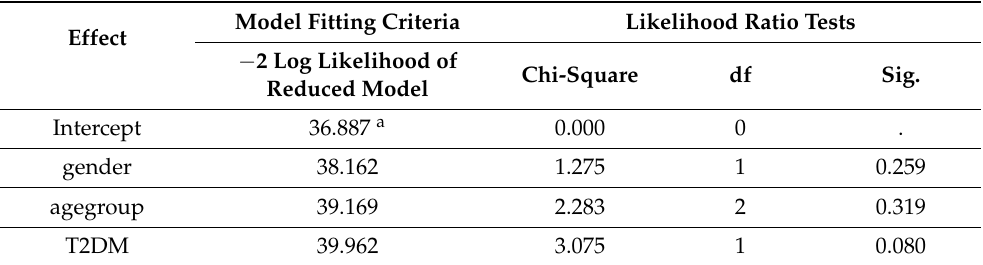
Table 10. Multinomial logistic regression analysis for the TNF-a - 308G/A genotypes. Likelihood Ratio Tests.